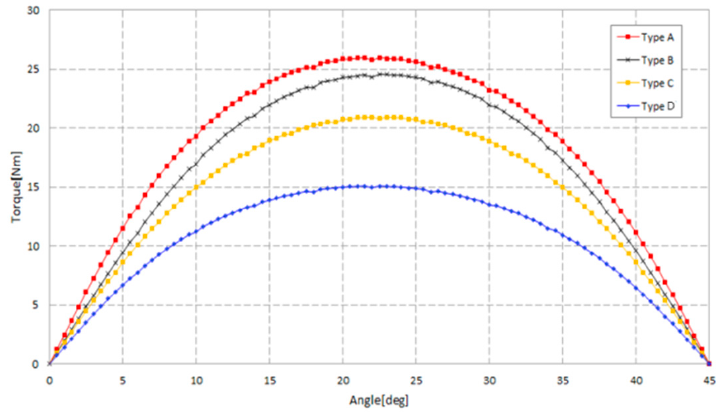
Figure 9. MAXWELL results show the calculated torque at different magnet alignment angles for all